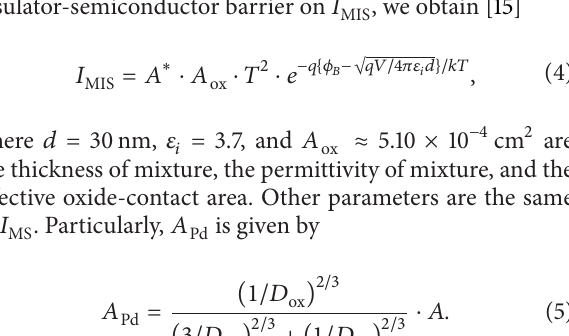
and (b) simulation result for comparison. RB